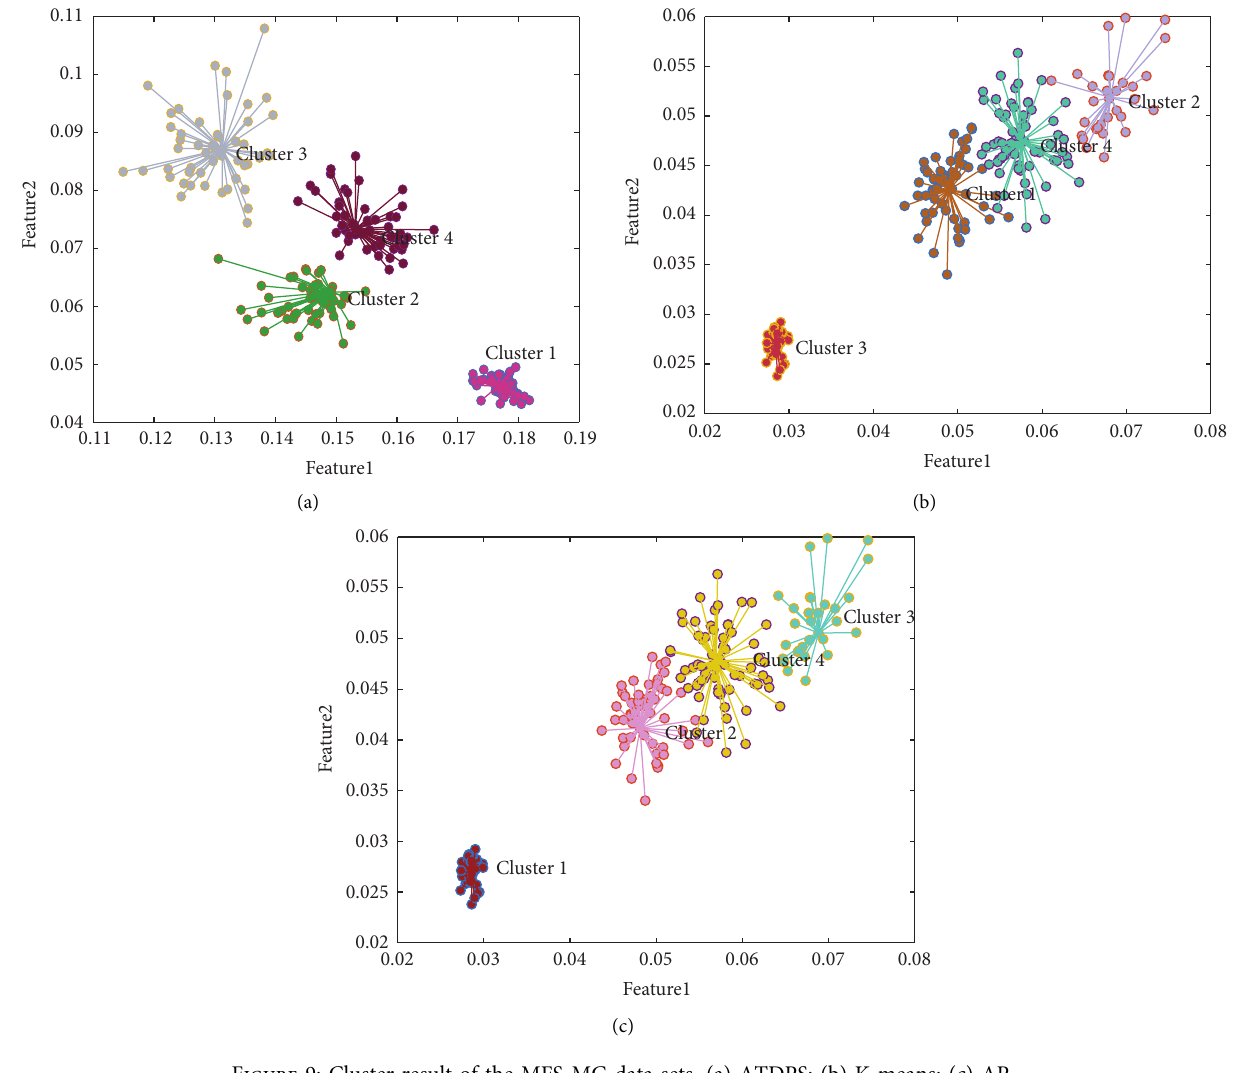
Figure 9: Cluster result of the MFS-MG data sets. (a) ATDPS; (b) K-means; (c) AP.